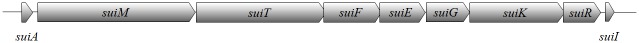
Genetic organization of the putative suicin 3908 gene cluster.